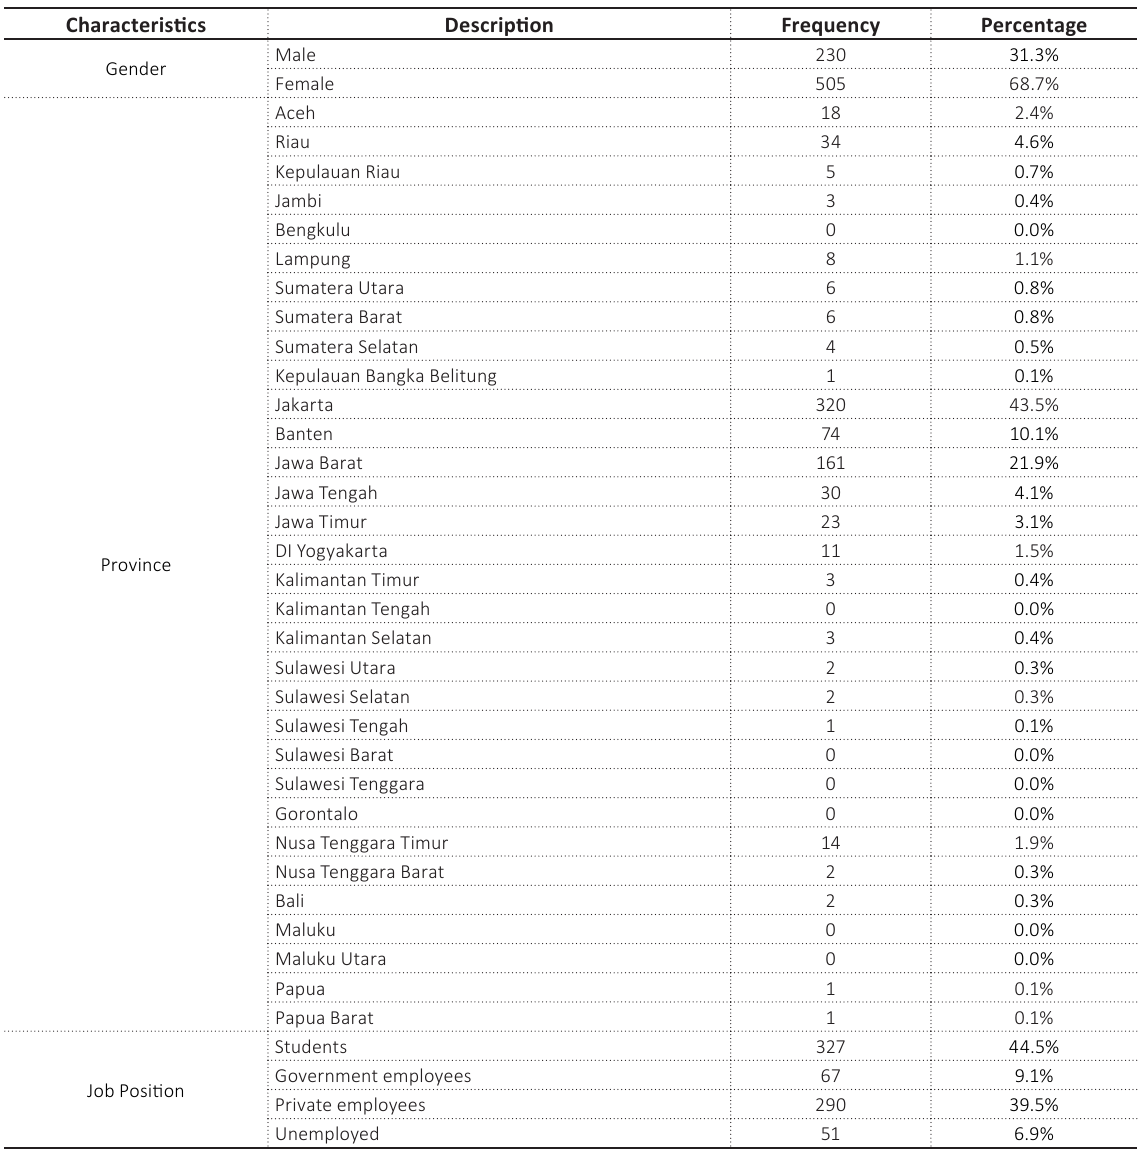
Table 2. Demographic